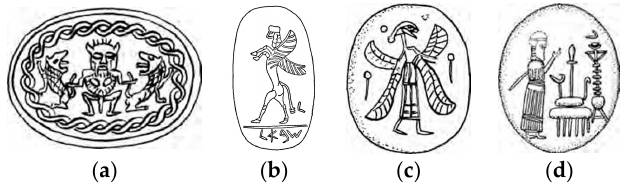
Figure 11. Other gods and mythological creatures: ( a ) ʿ Amman 62; ( b ) ʿ Amman 6; ( c ) Tall Safut